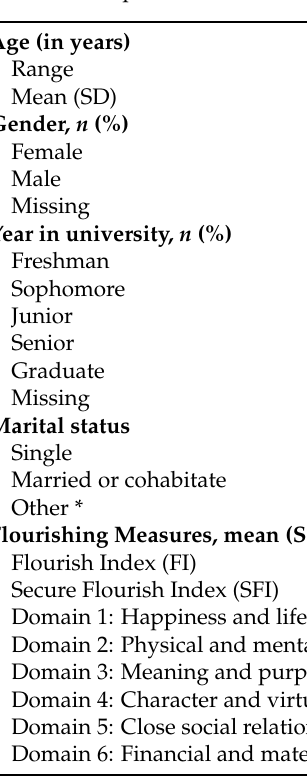
Table 1. Participant characteristics ( n =